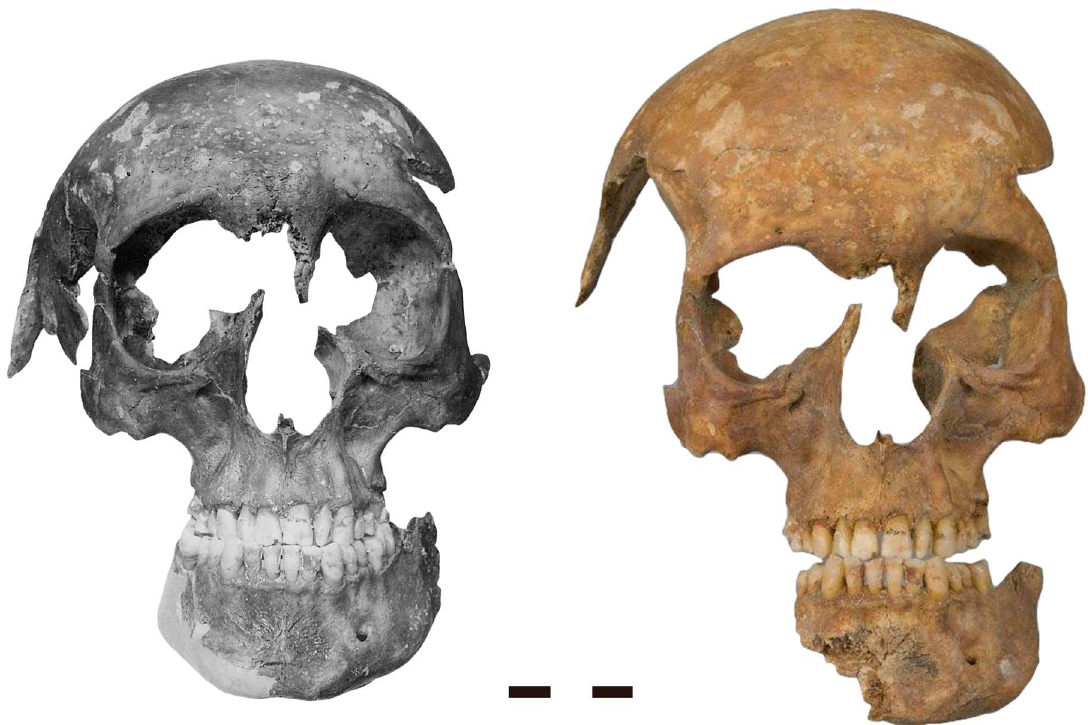
Fig 4. Preservation of the skull during the first exhumation compared with that of the second exhumation. Left: conditionin 1959, Right: conditionin 2012. Note the progressive weatheringof all edges. On the right, the mandible is not in occlusion,and the neurocranium is reconstructed in a different orientation to the viscerocranium than in 1959. Moreover, the fragments of the spider web fracture of the right temple have not been realigned.Scale bar 3